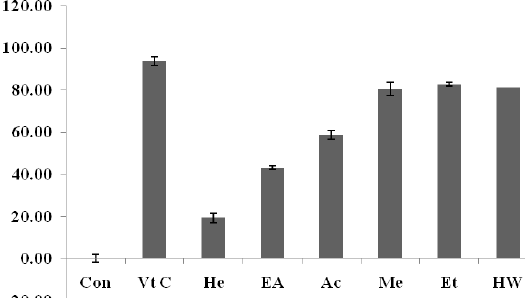
Figure 1. DPPH scavenging activity of solvent extracts of C.yabunikkei leaf (extract cont: 0.5 mg/mL, Ascorbic acid: 20 µ g/mL). The asterisk represents a value significantly different from the other groups ( p < 0.05). Values were the mean ± standard deviation ( n = 3) Vt C; ascorbic acid, He; hexane ex, EA; ethylacetate ez, Ac; acetone ex, Me; methanol ex, Et; ethanol ex, HW; hot water ex.